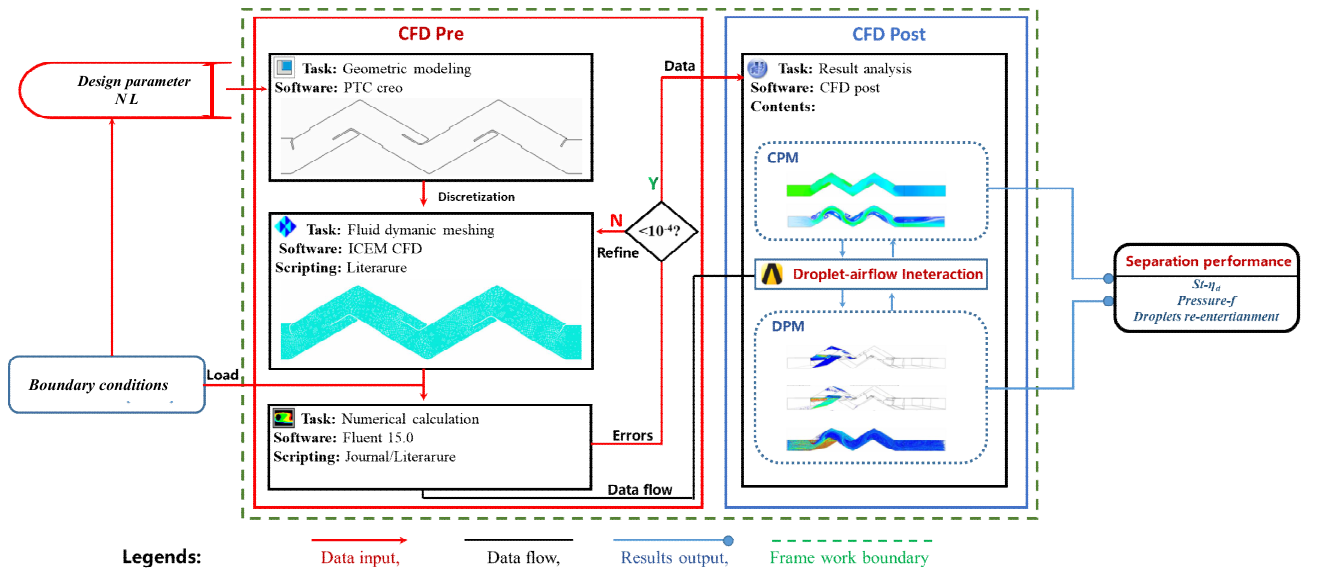
Table 1. Selected curved vane demisters for the given parameters and levels.